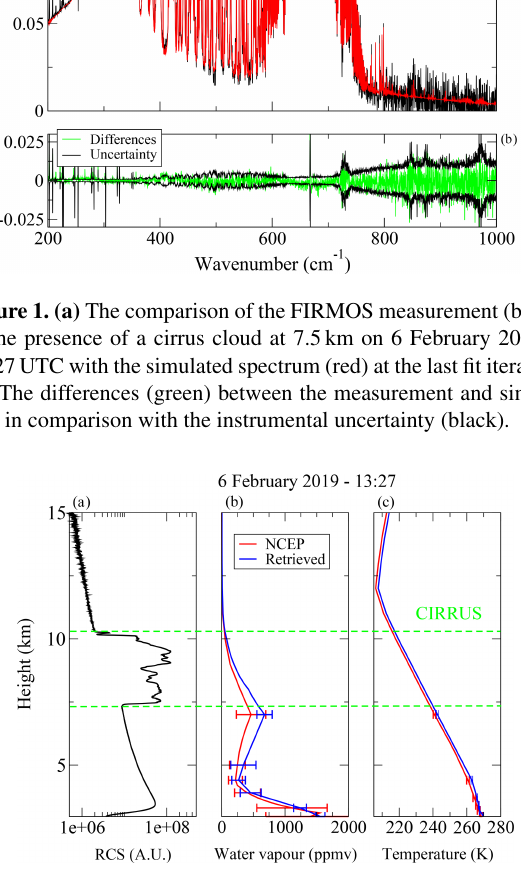
Figure 2. (a) The lidar range-corrected signal (RCS) as a function of the height above the ground corresponding to the measurement of Fig. 1. (b, c) The NCEP profiles (red curves) of the water vapour volume mixing ratio (vmr) and temperature together with the ones retrieved from FIRMOS data (blue